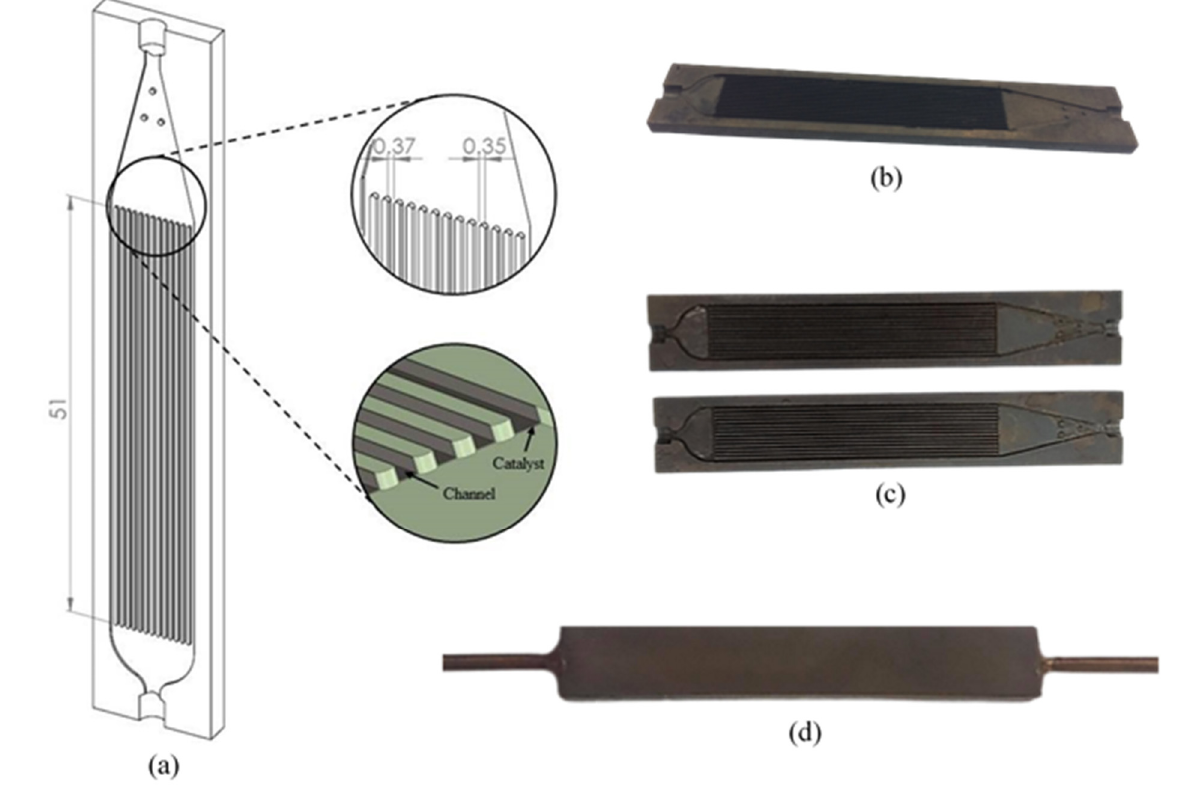
Figure 10. Two plates of micro-channeled stainless steel 316 L; ( a ) drawing scale, ( b ) after wash coating, ( c ) after burning binder at 500 ◦ C, and ( d ) reactor assembling by laser